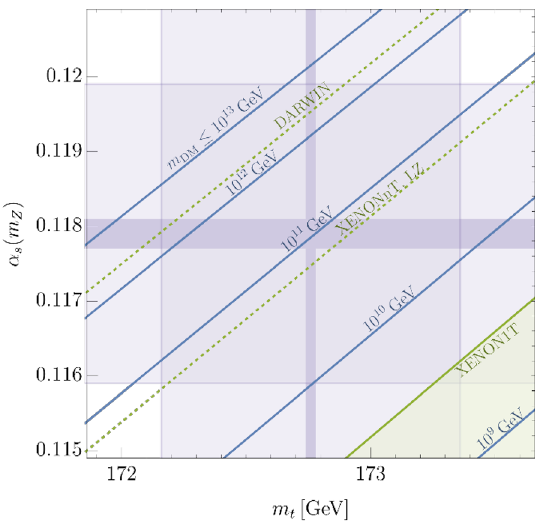
Figure 7 . Upper bound on the dark matter mass m DM as a function of the top quark mass m t and the strong coupling constant α s ( m Z ) shown in blue . Equivalently, the figure shows an upper bound on m t as a function of α s ( m Z ) and m DM , and a lower bound on α s ( m Z ) as a function of m t and m DM . The wider gray bands show the current 2 σ uncertainties of m t and α s ( m Z ) , and the narrower bands show the expected future uncertainties. Dark matter direct detection bounds are shown in green